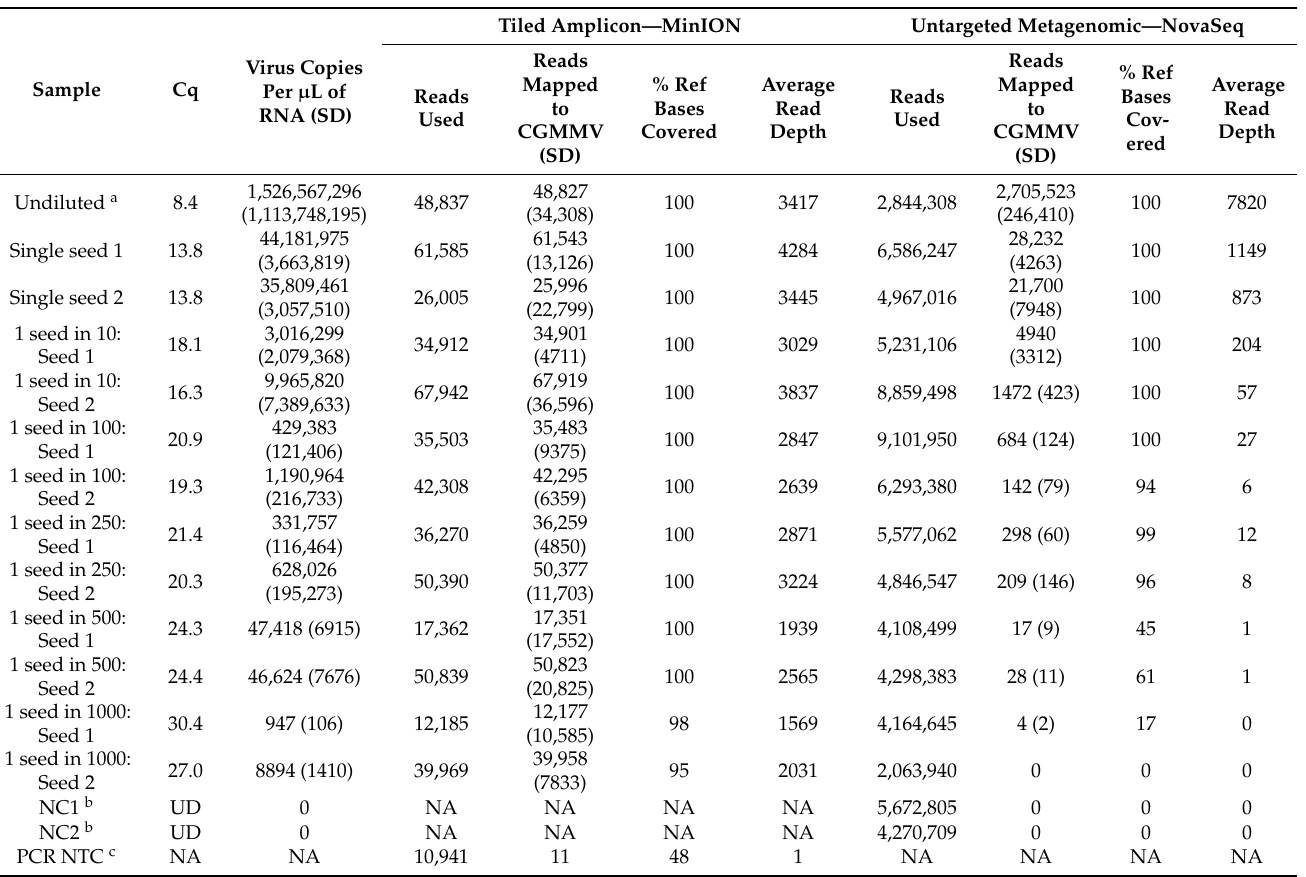
Table 2. The cucumber green mottle mosaic virus (CGMMV) seed panel dilution series samples and buffer control that were tested by quantitative RT-PCR, tiled amplicon nanopore sequencing and the untargeted metagenomic short read sequencing methods. Absolute quantification of virus copy number per µ L of RNA extract was calculated from the quantitative RT-PCR cycle quantification (Cq) value when compared to a standard curve (Tables S1 and S3). Tiled amplicon and the untargeted metagenomic sequence data is presented for the number (No.) of sequence reads generated for each sample after quality and length trimming, number of reads mapping to the 6377 nt reference CGMMV sequence (isolate NSW3-35), percentage (%) of CGMMV reference sequence bases covered, and average number of reads at each reference base (Average read depth). Values represent the average of three technical replicates. Standard deviation (SD) is given in